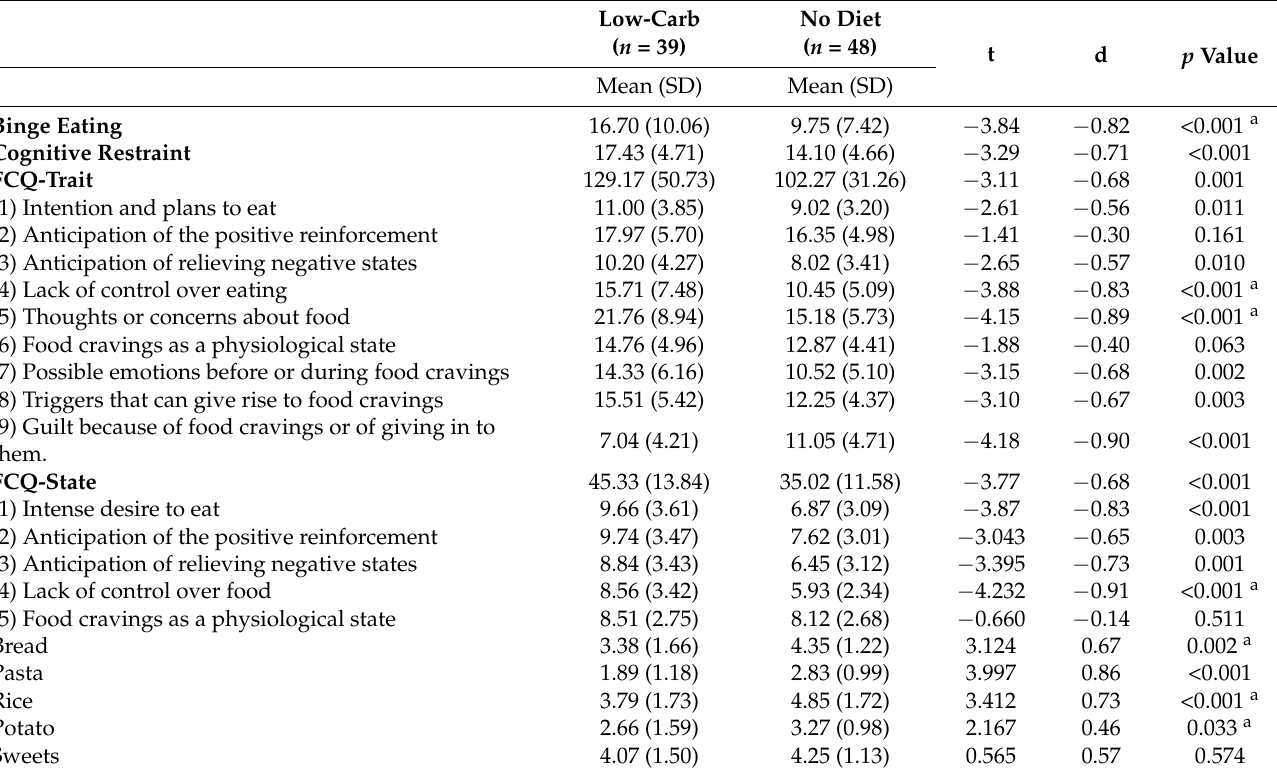
Table 1. Comparisons between eating behaviors, food cravings and food consumption between groups.